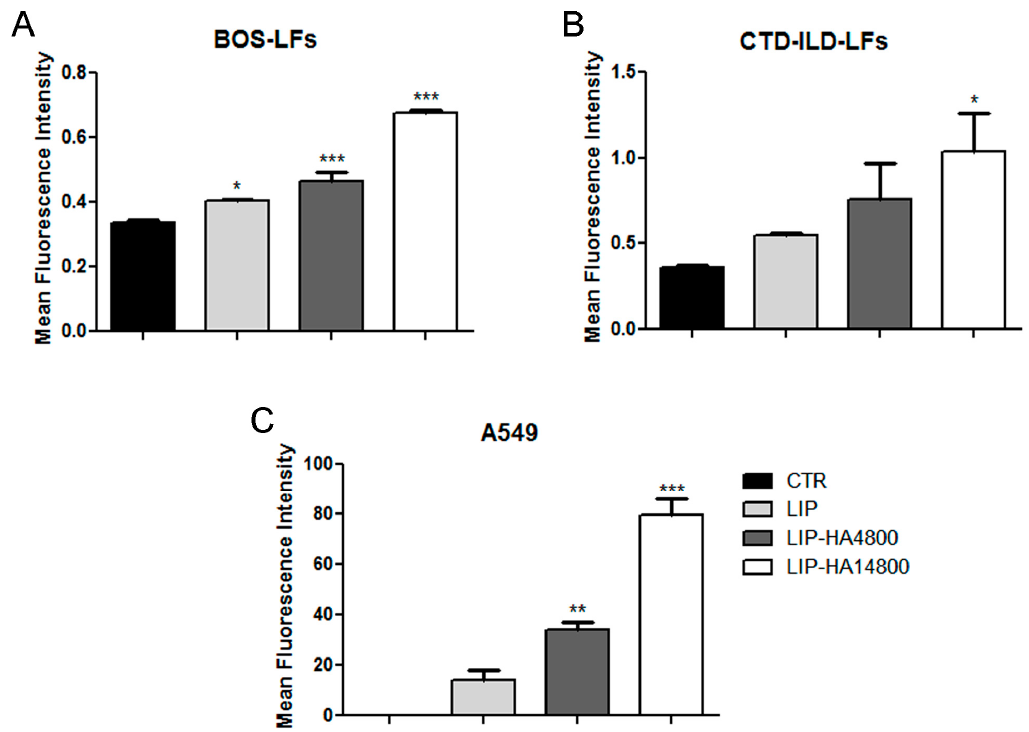
Figure 2. Flow cytometry analyses of fluorescently labeled LIP, LIP-HA4800, and LIP-HA14800 incubated with BOS-LFs ( A ), CTD-ILD-LFs ( B ), and A549 ( C ). Histograms represent mean of mean fluorescence intensity of liposomes ± standard deviation. *, p < 0.05 vs. CTR; **, p < 0.01 vs. CTR; ***, p < 0.001 vs. CTR.